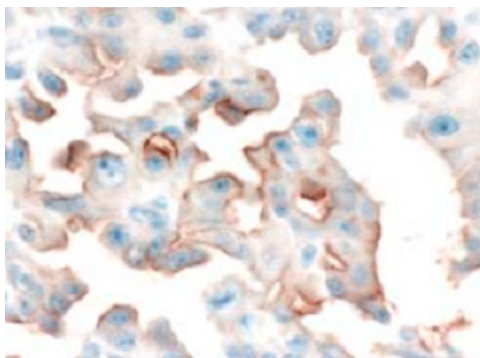
Figure 5. Immunohistologic finding of ABCG2 in peritoneal metastasis, using anti-ABCG2 mouse monoclonal antibody BXP-21 (1:200 dilution; Convance Research 152 Products, Emeryville, CA, USA). ABCG2 expression is detected on the cell membrane.